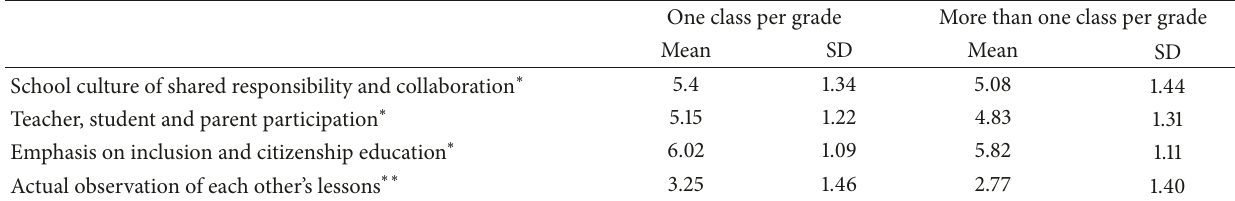
Table 9: Differences in teacher perceptions and collaboration experiences by size of